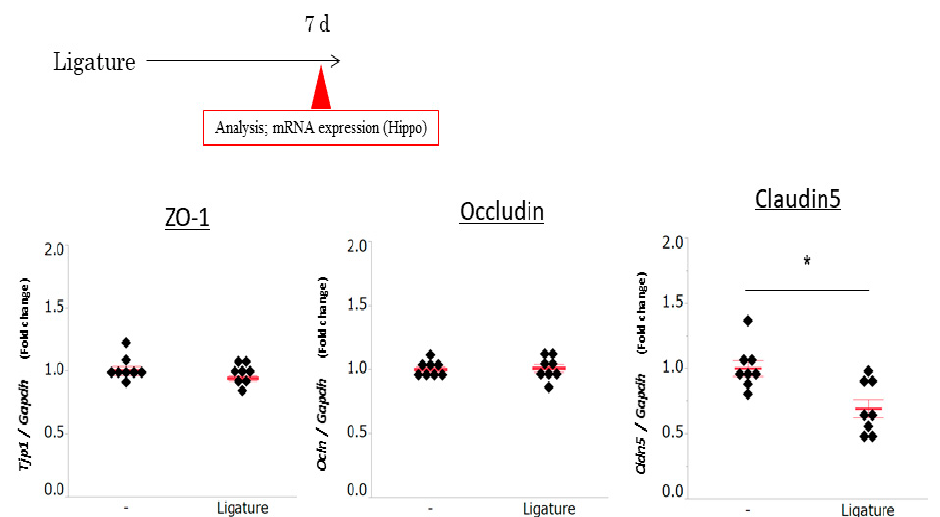
Figure 3. Effects of ligature-induced PD on tight junction-related protein levels in the hippocampus. One week after ligation, the hippocampus was collected and the expression levels of occludin, ZO-1, and claudin 5 were measured (mean ± SE, n = 8/group). * p < 0.05 significantly different from the control, the Student’s t- test.